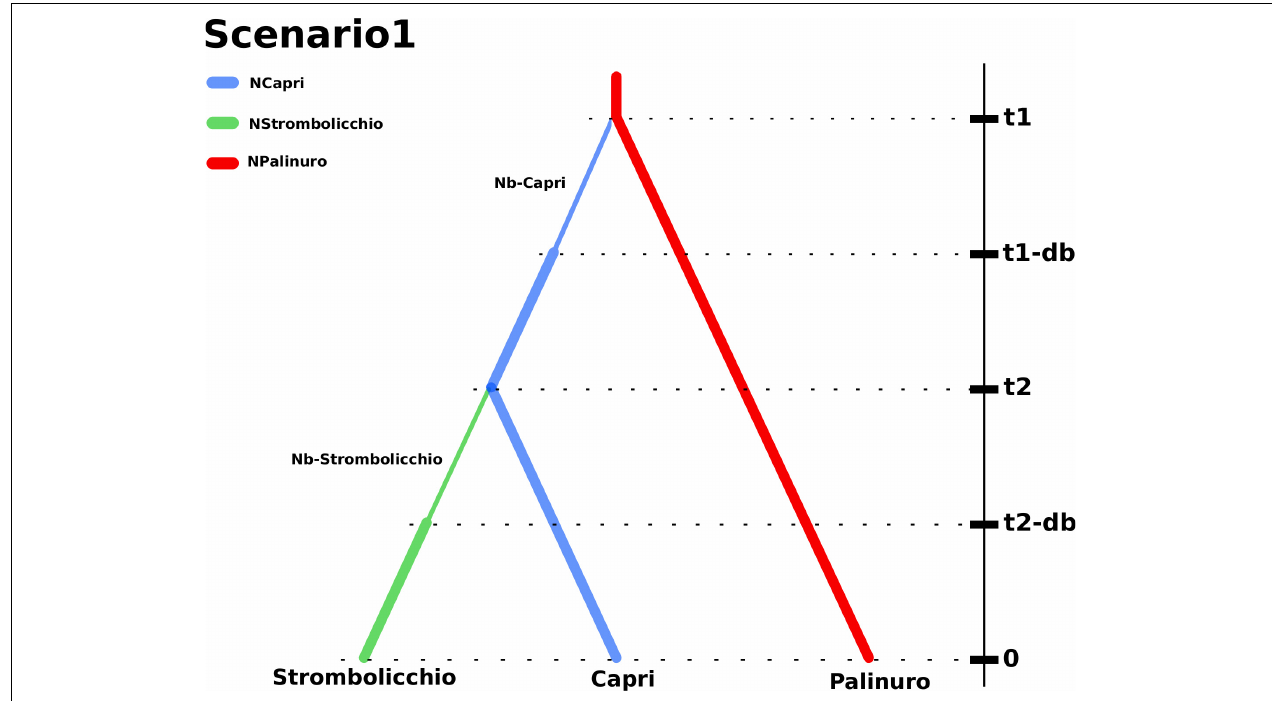
FIGURE 7 | Demographic history of Eokochia saxicola populations implemented by DIY ABC. Scenario 1 represents the most likely hypotheses of the demographic history: the Strombolicchio population was derived from the Capri population, which originated from the Palinuro population. The branch colors indicate discrete population size parameters in the model. t1 represents the split time between the Palinuro population and Capri population, while t2 represents the split time between the Capri population and Strombolicchio population. The thin branch width indicates bottlenecks of duration db (t1-db and t2-db) with effective population sizes of Nb (Nb-Capri and Nb-Strombolicchio). Note: Time is not to scale. TABLE 3 | Prior values (minimum and maximum, with uniform distribution) for the parameters used for the demographic scenarios and posterior values (mean; median; quantile 5%, and 95% and variance) were estimated from Scenario 1 in the DIYABC approach. Parameter Prior parameters Posterior parameters minimum Maximum mean median quantile 5% quantile 95% variance Effective population